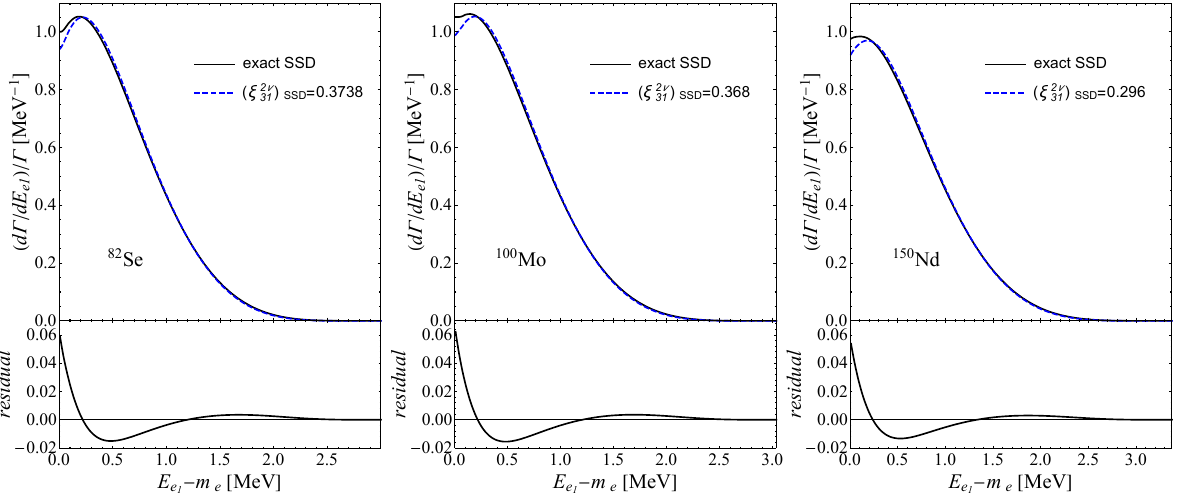
Figure 5. Normalized single electron spectra for 82 Se, 100 Mo and 150 Nd assuming the single state dominance. We compare the exact SSD [21,22] with the Taylor expansion with ratio of the nuclear matrix elements fixed by